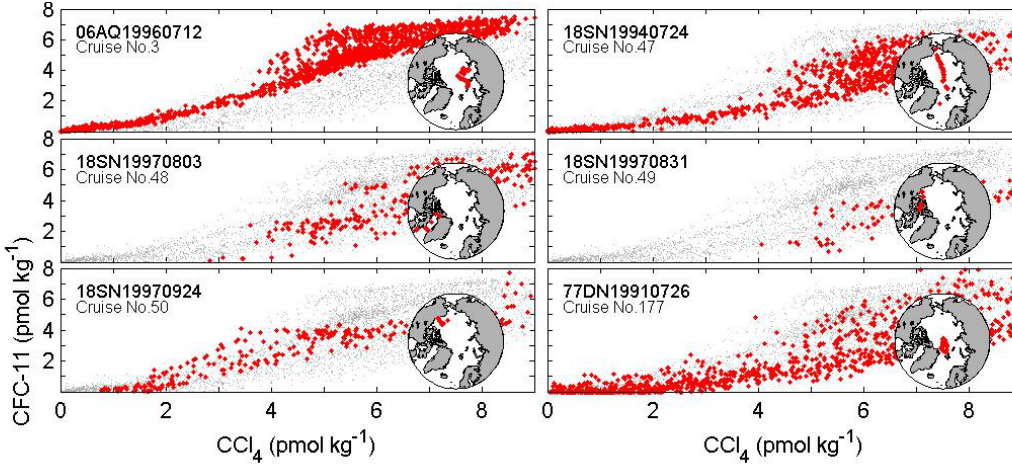
Figure 17. CFC-11 vs. CCl 4 . See Fig. 11 for specifications.